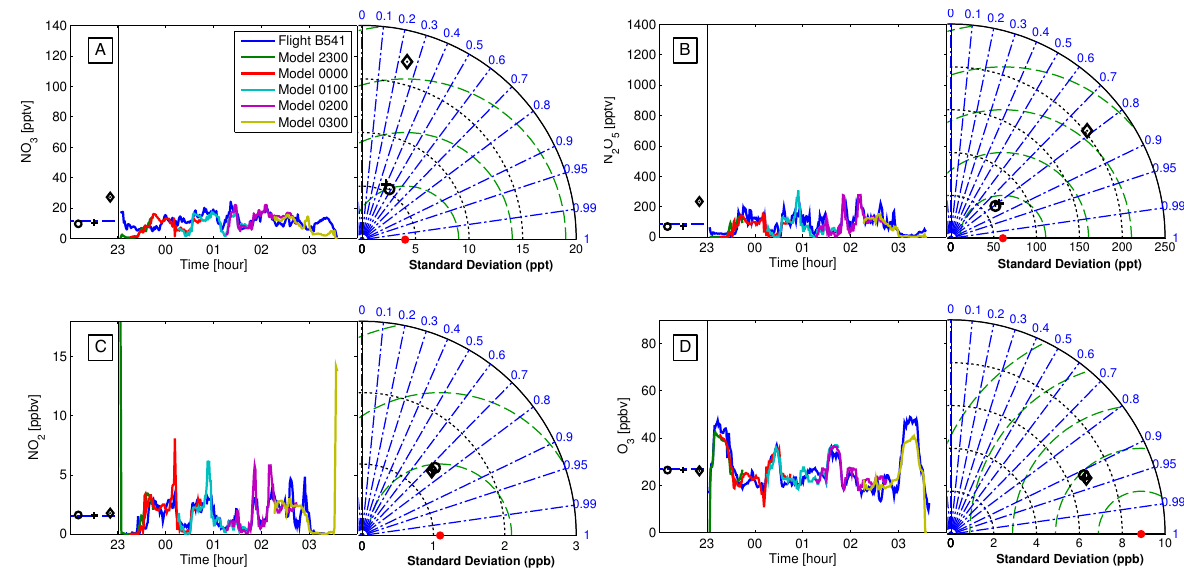
Figure 8. Flight track measurement–model comparisons for key nitrate species for flight B541. Main plots show 1min averaged measure- ments (blue lines), and data from the “het on” model scenario (multi-coloured lines) for NO 3 , N 2 O 5 , NO 2 , and O 3 ( a–d , respectively). The side panels on the left of each plot show the mean values for each diagnostic species along the flight track, while the Taylor diagrams on the right shows the standard deviations of, and correlations between, the individual model scenarios and measurements. Symbols representing the different model scenarios are the same as those used in Fig.